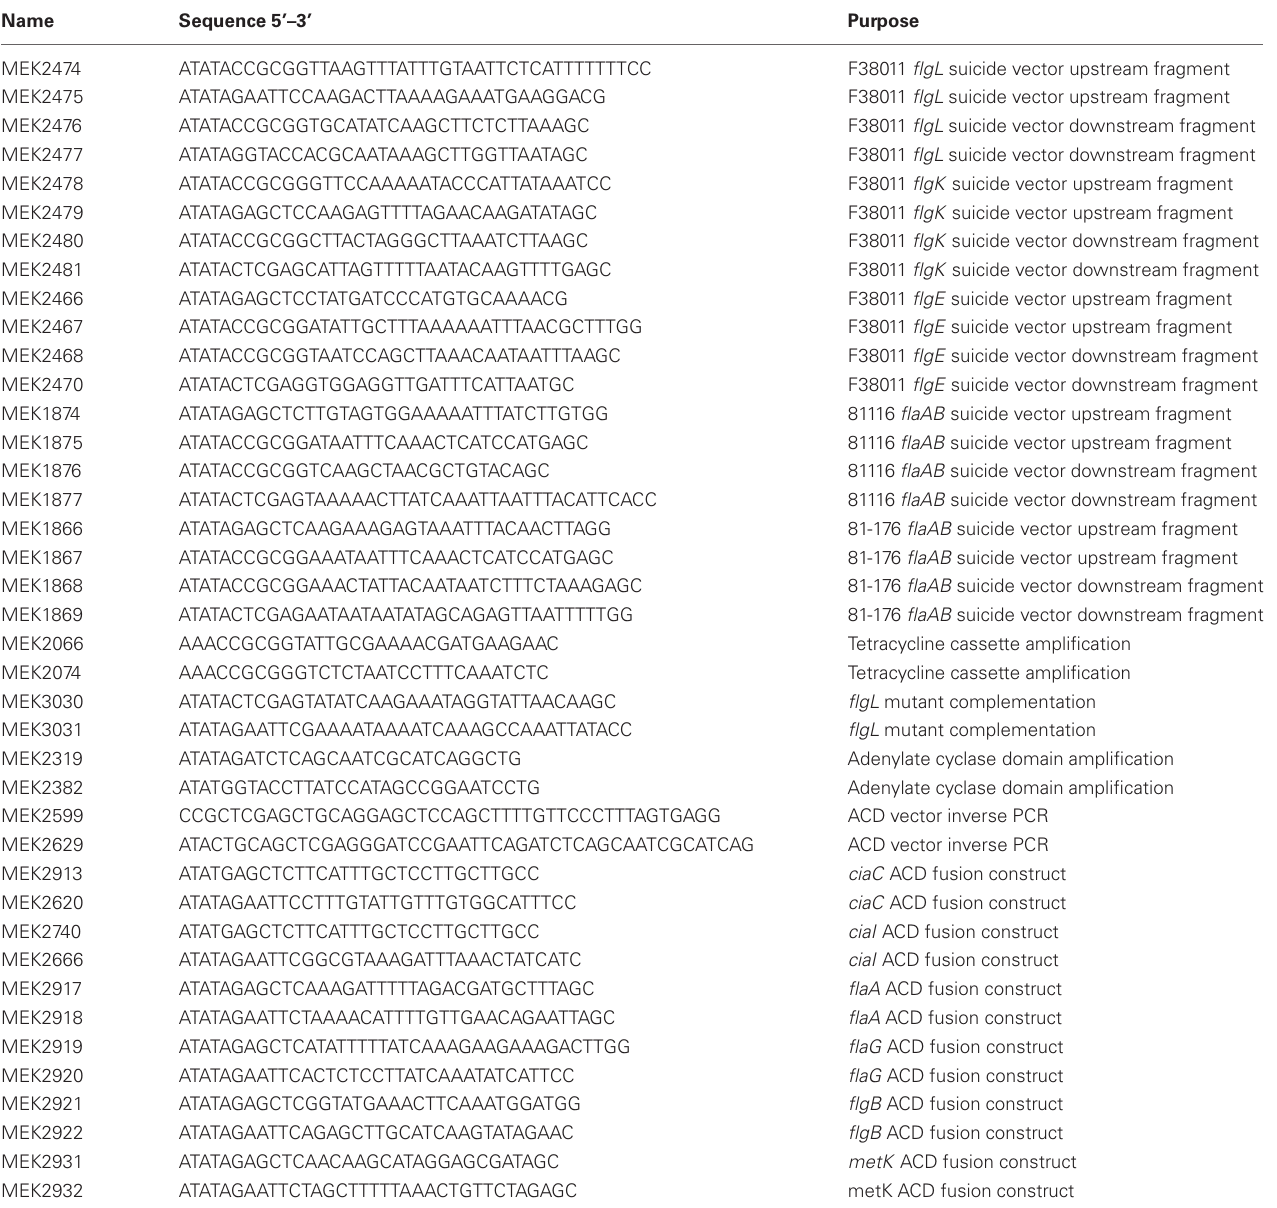
Table A1 | Primers used in this